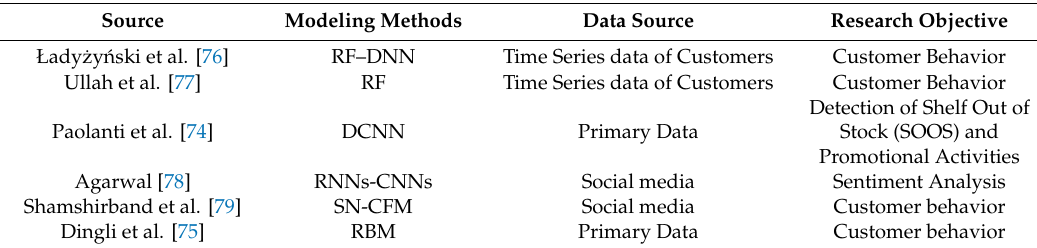
Table 4. Notable machine learning and deep learning methods in